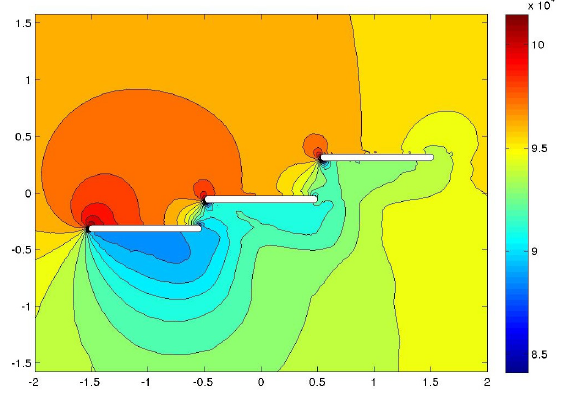
Fig. 8. Time development of y-components of aerodynamic forces produced by the developed solver in comparison to the results obtained be the commercial CFD software package AN- SYS Fluent.